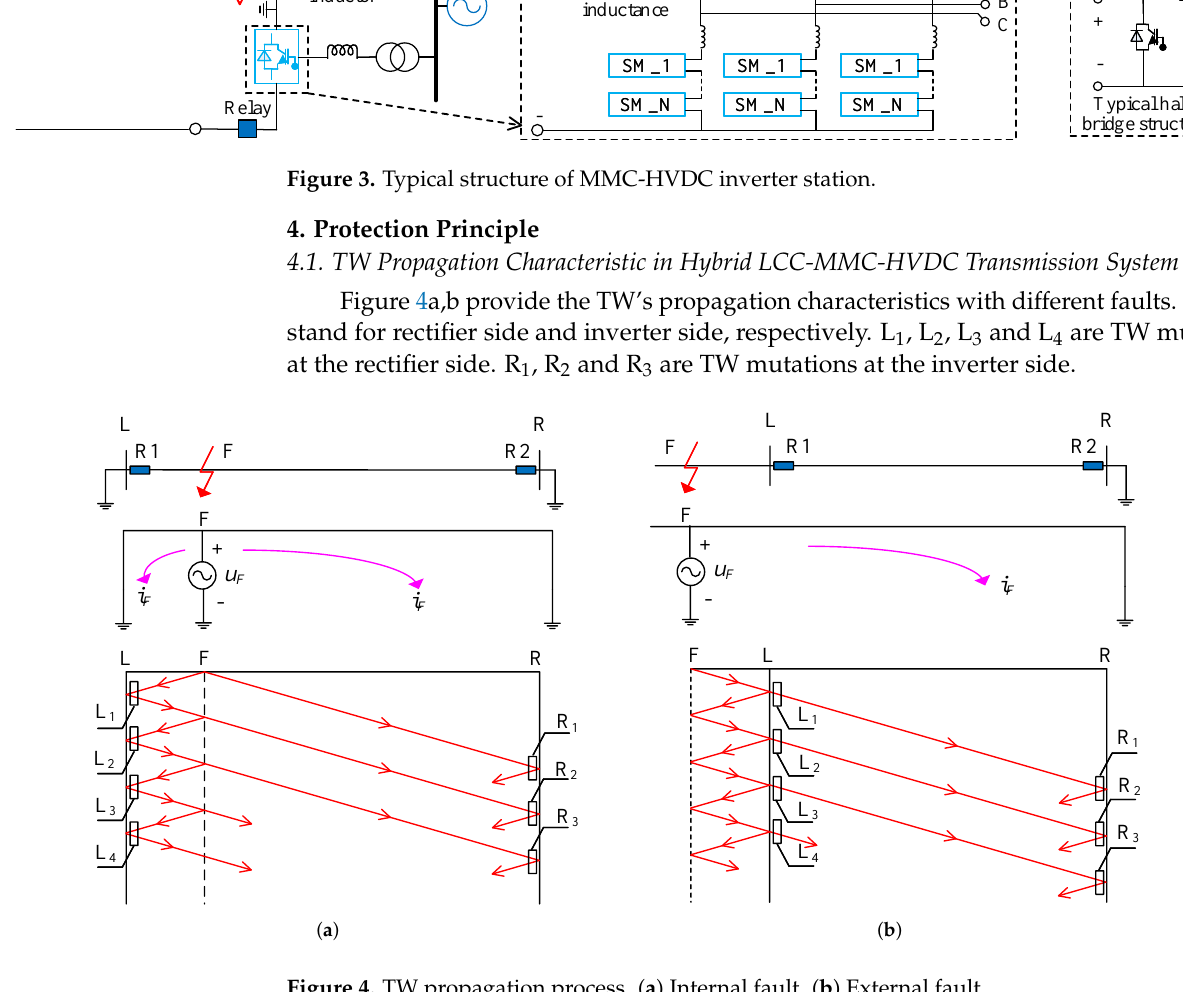
Figure 4. TW propagation process. ( a ) Internal fault. ( b ) External fault. Tables 1 and 2 describe both terminals’ TW mutations under different fault types. u ( t ) and i ( t ) represent VTW and CTW signals, respectively. λ Lu and λ Li represent the